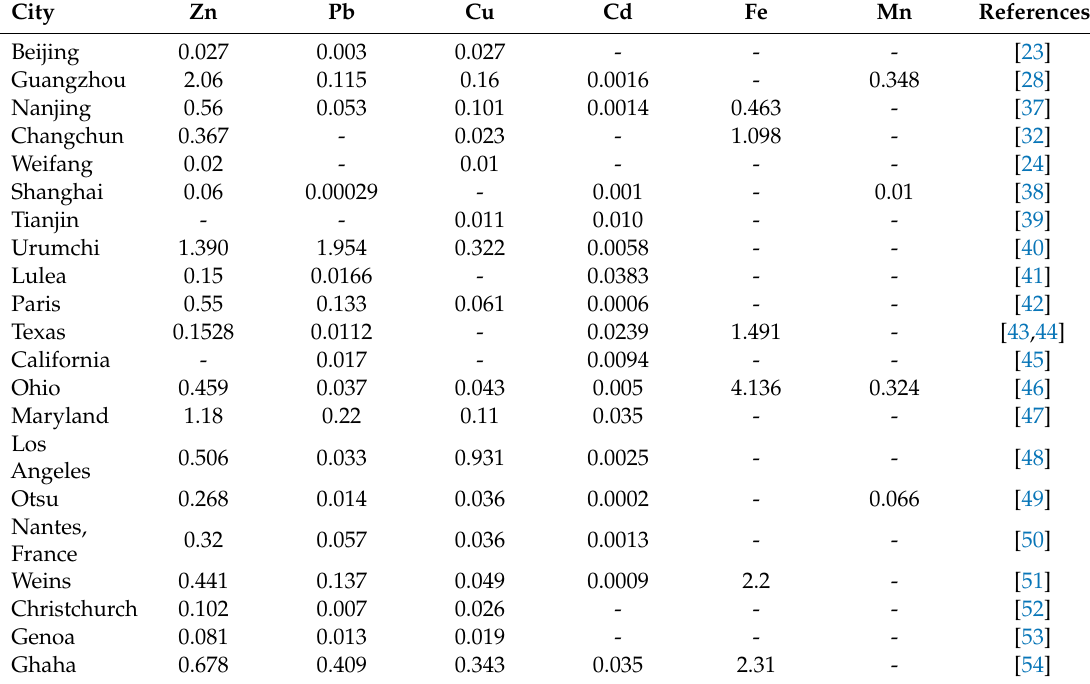
Table 2. Urban pavement runo ff heavy metal concentration (mg L − 1